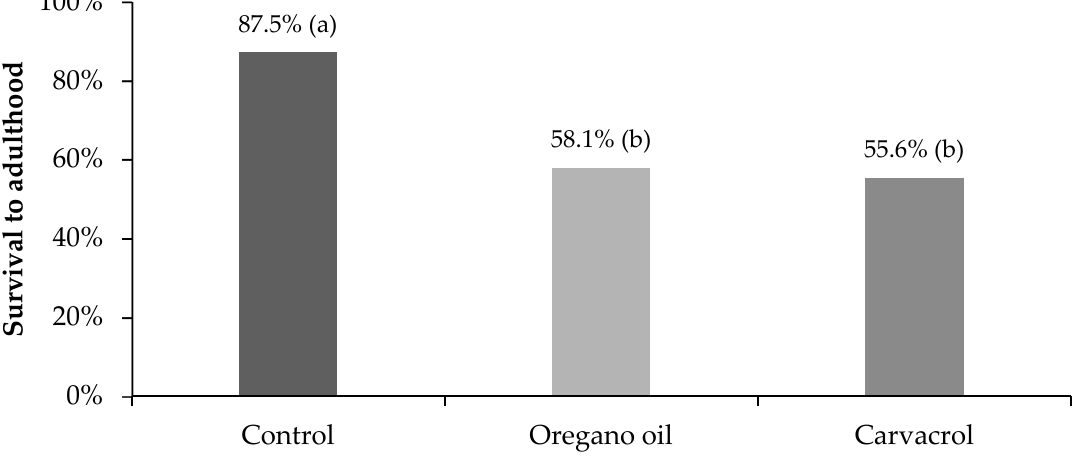
Figure 3. Survival (%) until adulthood of Cx. pipiens biotype molestus mosquitoes that remained alive after 24 h exposure of 3rd–4th instar larvae to LC 50 concentrations of oregano oil ( n = 74) and carvacrol ( n = 99), and to water solution of 2% DMSO (control) ( n = 80). Percentages in a column followed by a different letter are significantly different ( p < 0.05).